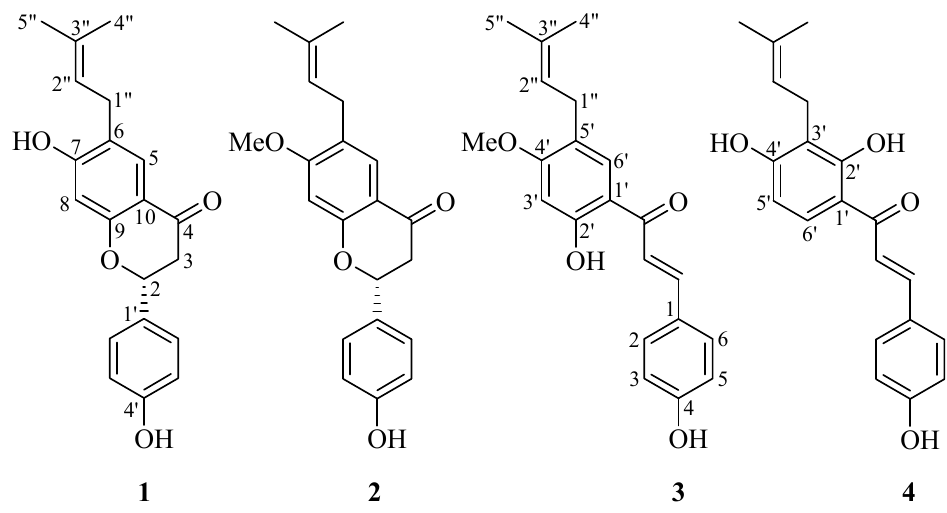
Figure 1. The structures of compounds 1 – 4 isolated from Psoraleae Fructus . ( 1 ) Bavachin, ( 2 ) Bavachinin, ( 3 ) Bavachalcone, ( 4 ) Isobavachalcone.